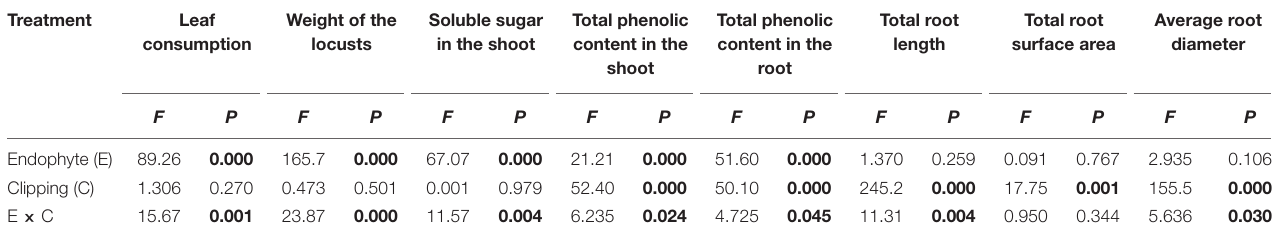
TABLE 1 | Two-way ANOVA for leaf consumption and physiological indexes of endophyte-infected (EI) and endophyte-free (EF) Achnatherum sibiricum under the clipping treatment. Treatment Leaf Weight of the Soluble sugar Total phenolic Total phenolic Total root Total root Average root consumption locusts in the shoot content in the content in the length surface area diameter shoot root